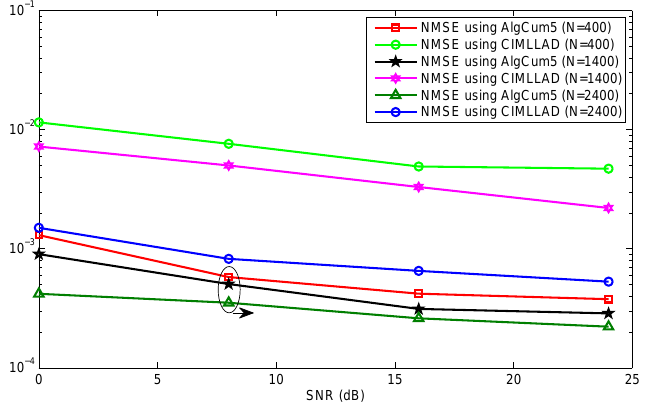
Figure 5. Comparison of NMSE in estimating the system I for different SNR and data input N .